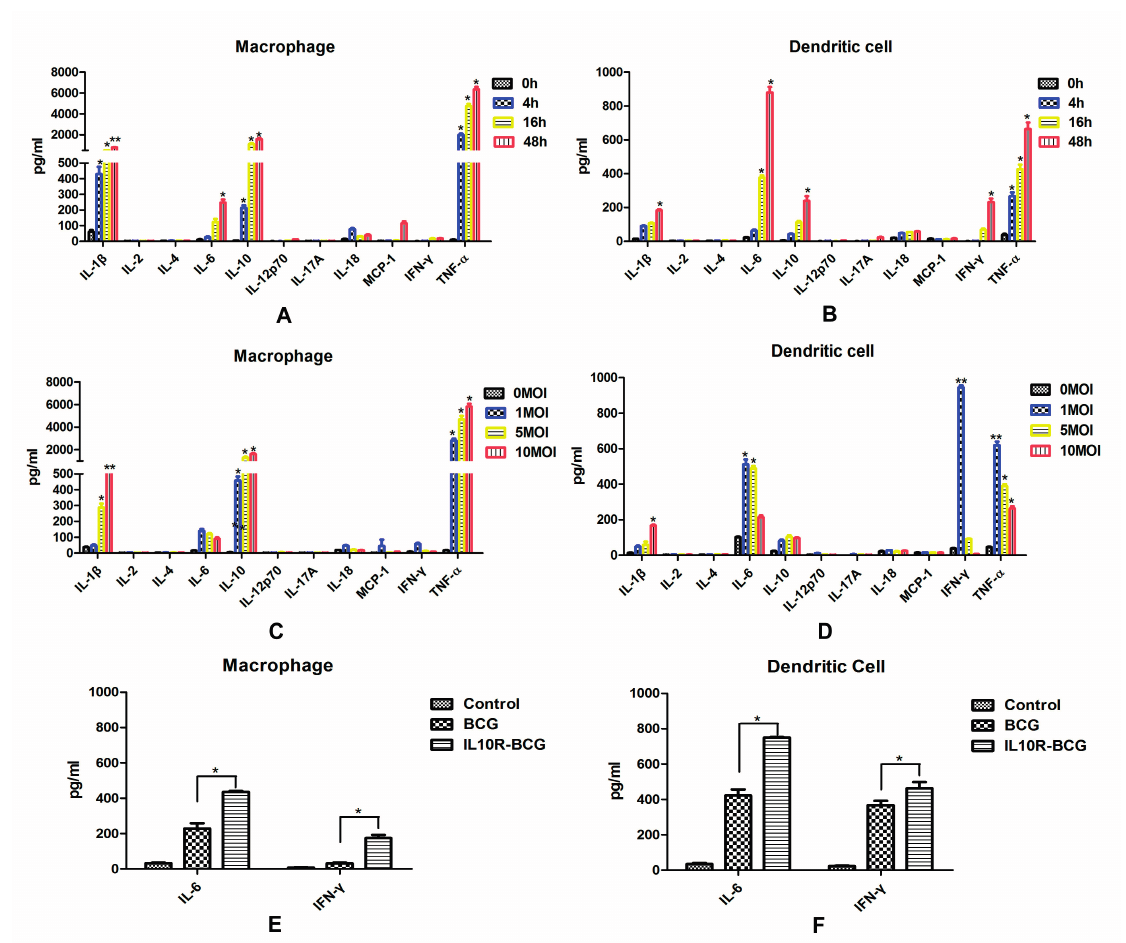
Figure 4. Kinetics of cytokine production following BCG-infected splenic DCs and M Φ s. Splenic macrophages ( A ) and dendritic cells ( B ) were infected with BCG at a MOI of 5, and the cell culture supernatants were collected and detected at different time points after infection; Splenic macrophages ( C ) and dendritic cells ( D ) were infected with different MOIs of BCG, and the cell culture supernatants were collected and detected at 16 h after infection; IL-6 and IFN- γ production increased significantly in M.bovis BCG-infected M Φ s ( E ) and DCs ( F ) when the effect of IL-10 was blocked by soluble IL-10R. Data depicted represent the mean values ± SEM. Statistical significance was determined by a Student’s t -test ( * p < 0.05, ** p <